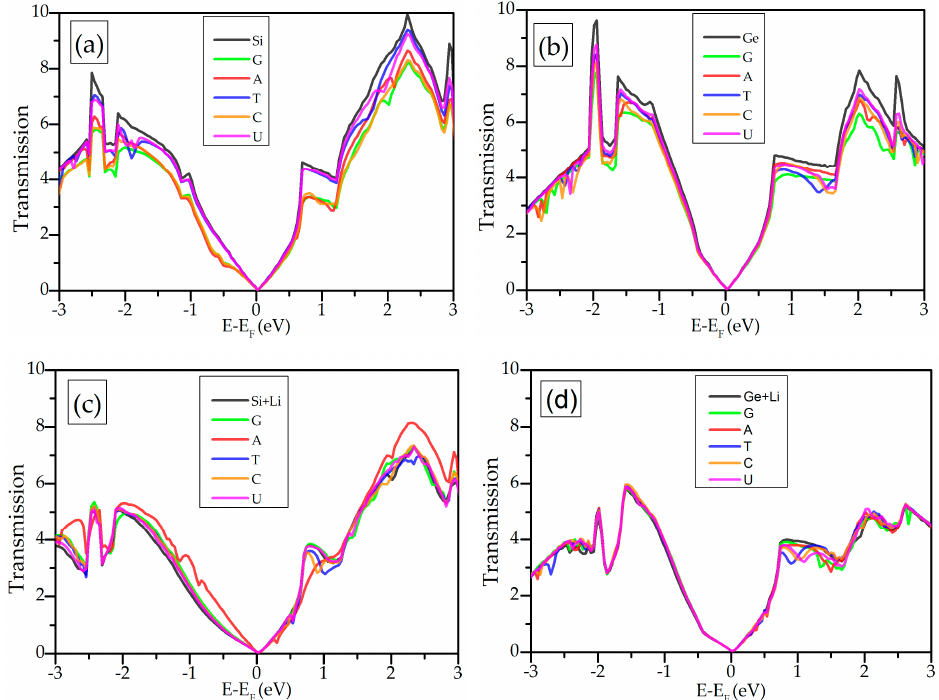
Figure 7. Transmission as a function of energy for each nucleobase on ( a ) silicene, ( b ) germanene, ( c ) Li-supported silicene, and ( d ) Li-supported germanene.